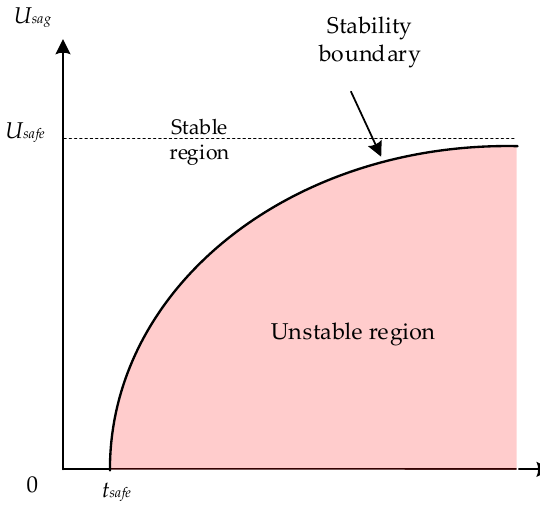
Figure 4. Diagram of the transient voltage stability boundary.